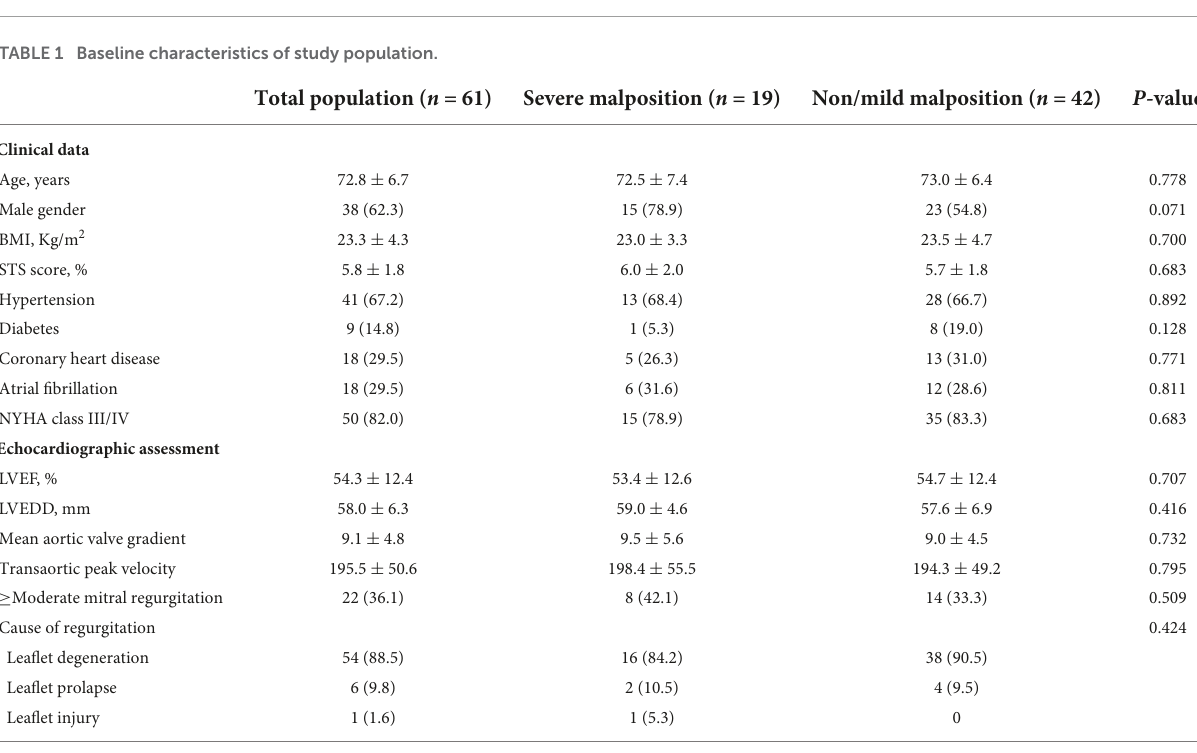
FIGURE2 The ROC curves of (A) prediction of hemodynamically relevant consequences by implantation depth and (B) prediction of severe malposition by the three STJ indicators. AUC, area under the curve; ROC, receiver operating characteristic.